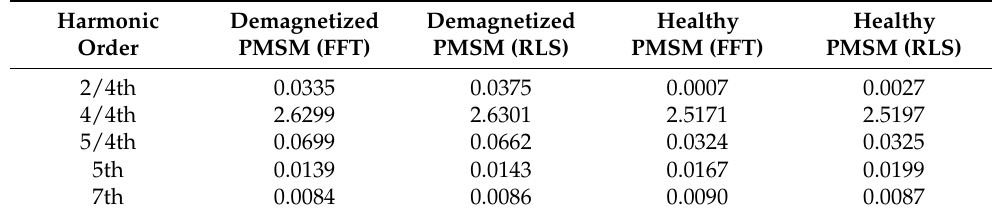
Table 3. Magnitude of each fault-related harmonic component in current with different algorithms and different health status (unit: A).